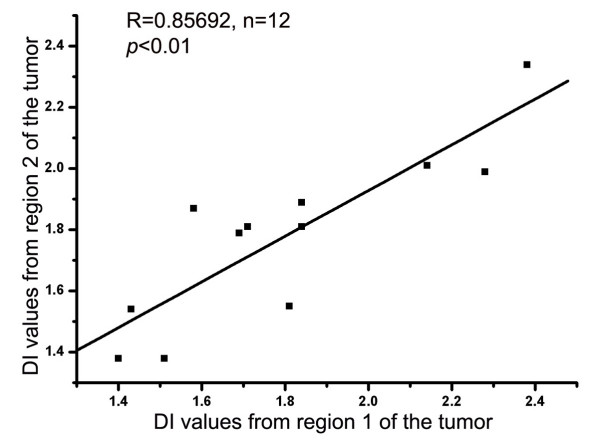
Correlation of DI values on ICS between two different tissue blocks from the same BAC. Note that there is a good correlation between the DI values of the aneuploid peaks in tissues from two sites of the same BAC.